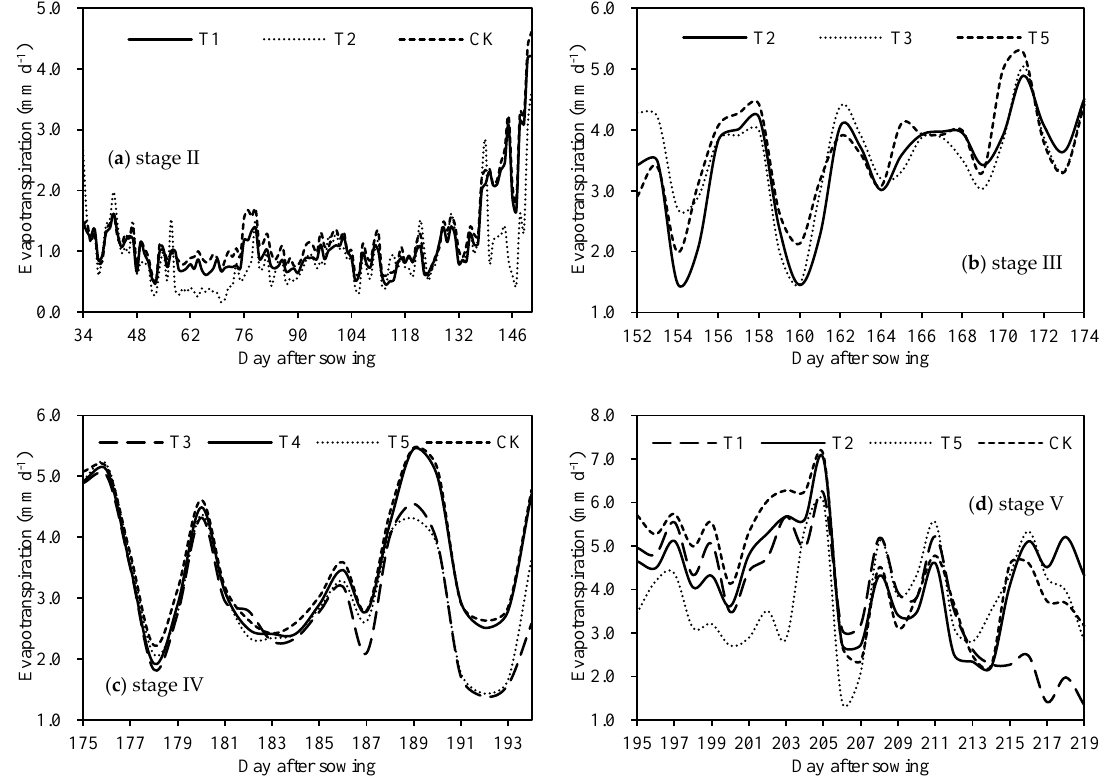
Figure 3. Observed daily wheat evapotranspiration during each growth stage for different treatments. ( a ) stage II: tillering stage; ( b ) stage III: elongation stage; ( c ) stage IV: heading stage; ( d ) stage V: milk-ripe stage.